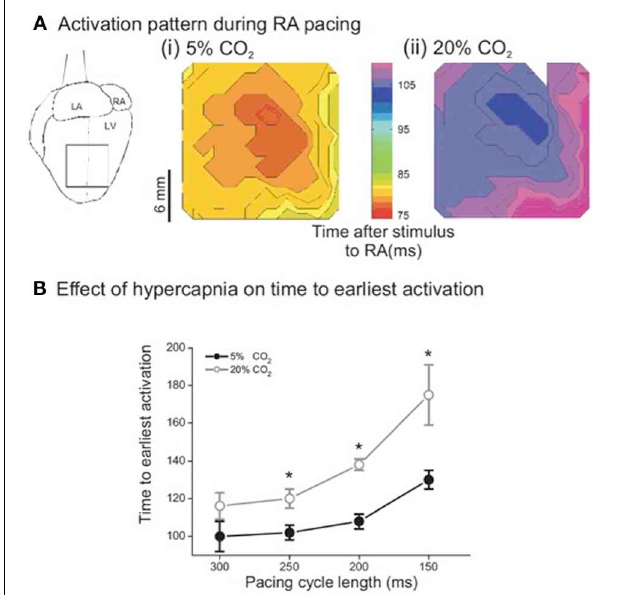
FIGURE 1 | (A) Sample isochronal maps of left ventricular (LV) epicardial activation during right atrial pacing. (i) Shows the activation pattern during normal pH conditions. The color bar indicates the time from stimulus to epicardial activation in ms. (ii) Is the same area of LV epicardium during acidic conditions—note that activation is delayed but the pattern is unchanged. (B) Effect of pacing cycle length on time to earliest epicardial activation. There was significant slowing of conduction from a PCL of 300ms down to 150ms in both normal and acidic conditions. In addition, there was significant slowing in acidic conditions when compared to the same PCL in normal conditions. ( n = 5 except PCL 300ms where n = 4, ∗ p < 0 .